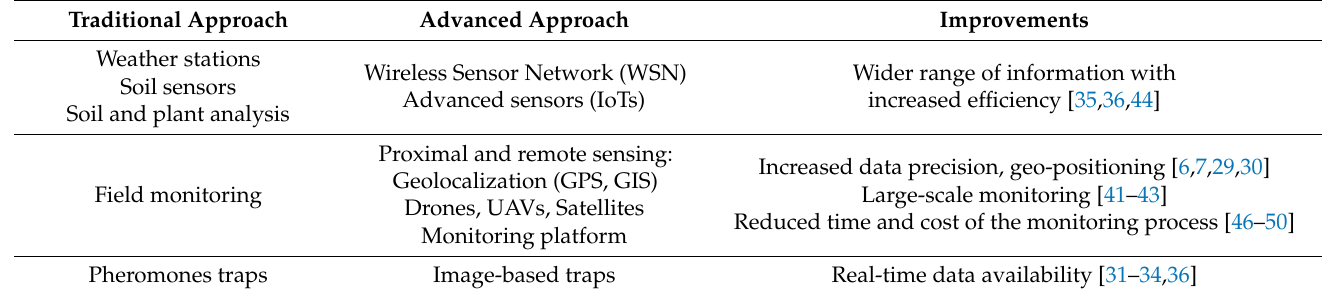
Table 1. Tools adopted for surveillance and monitoring, according to the traditional approach, and possible improvements provided by a more advanced, digital-based